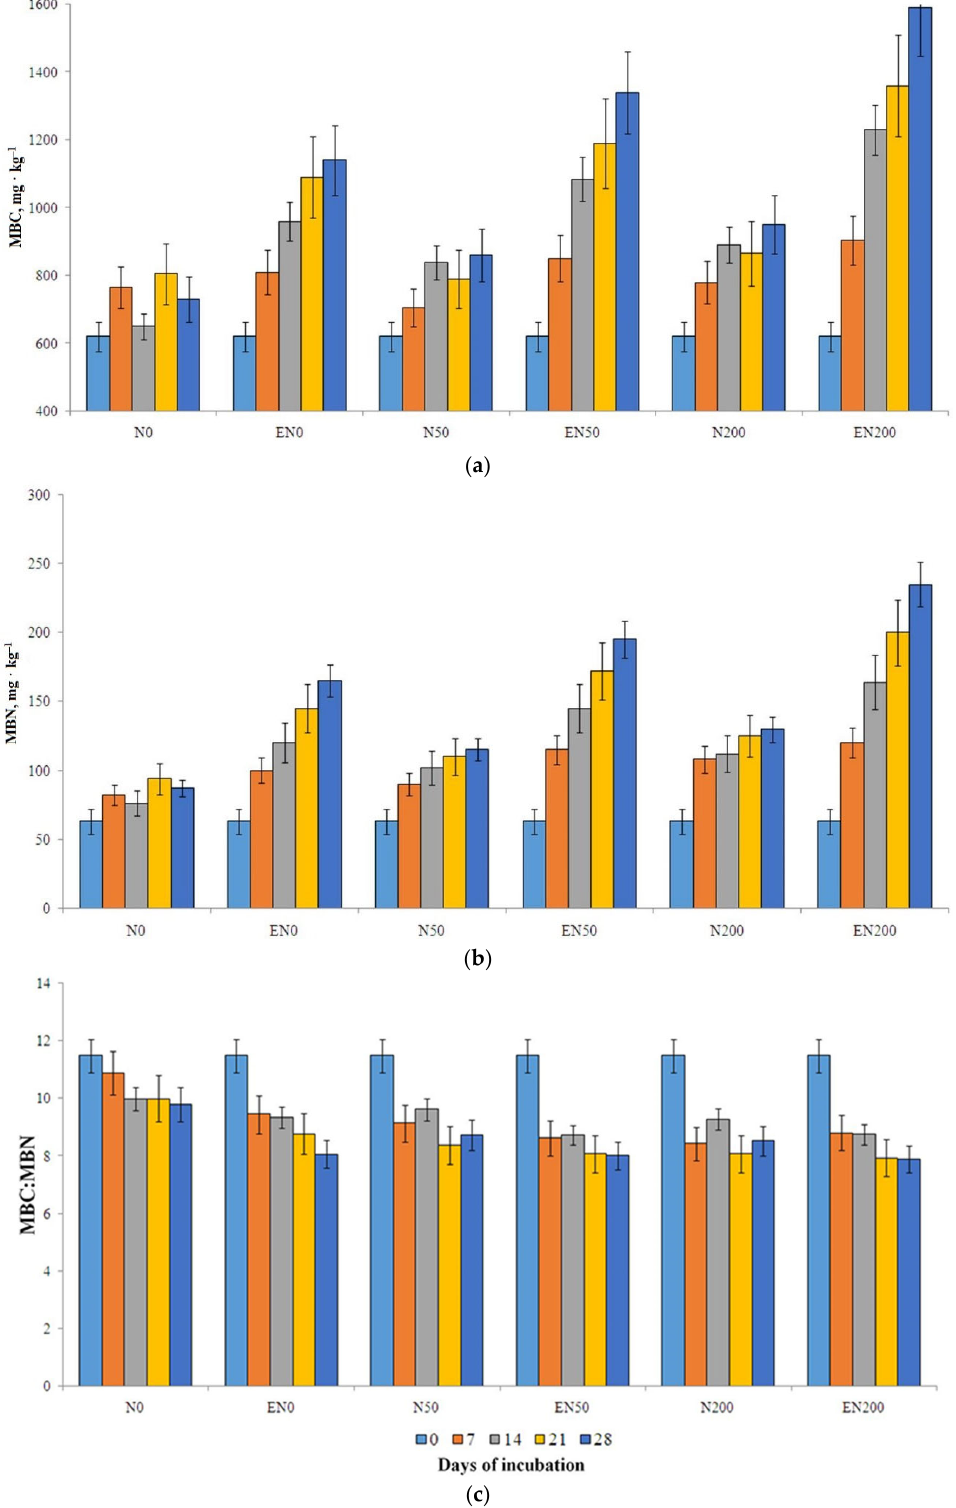
Figure 5. Dynamics of soil microbial biomass carbon ( a ), soil microbial biomass nitrogen ( b ) and MBC:MBN ratio ( c